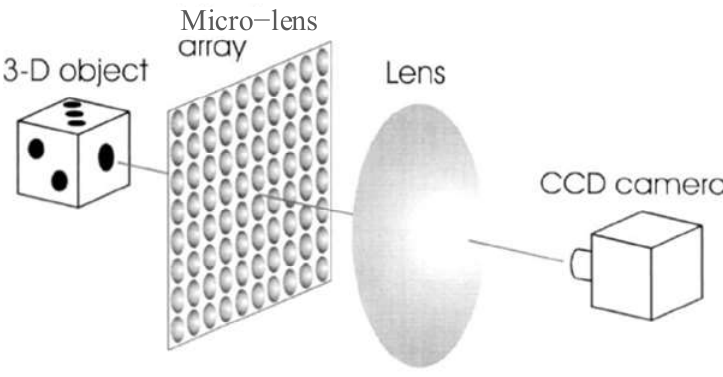
Figure 3. Optical system for obtaining image arrays [15].